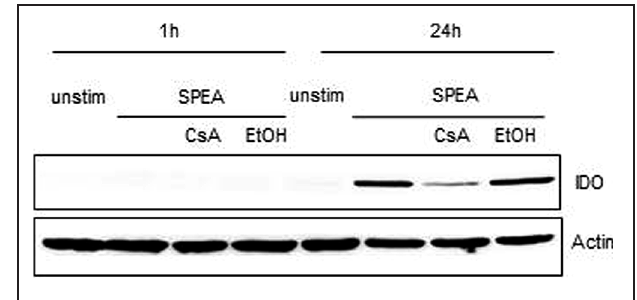
FIGURE 8 | Indoleamine 2,3-dioxygenase expression after SPEA stimulation. CD14 + monocytes were stimulated for 1 h or 24 h with 100 ng/ml SPEA and 1 μ M CsA (Ethanol was used equal to the amount of CsA). Cells were lysed and analyzed by western blot for IDO. ß-Actin as loading control was displayed. Shown is one representative experiment out of